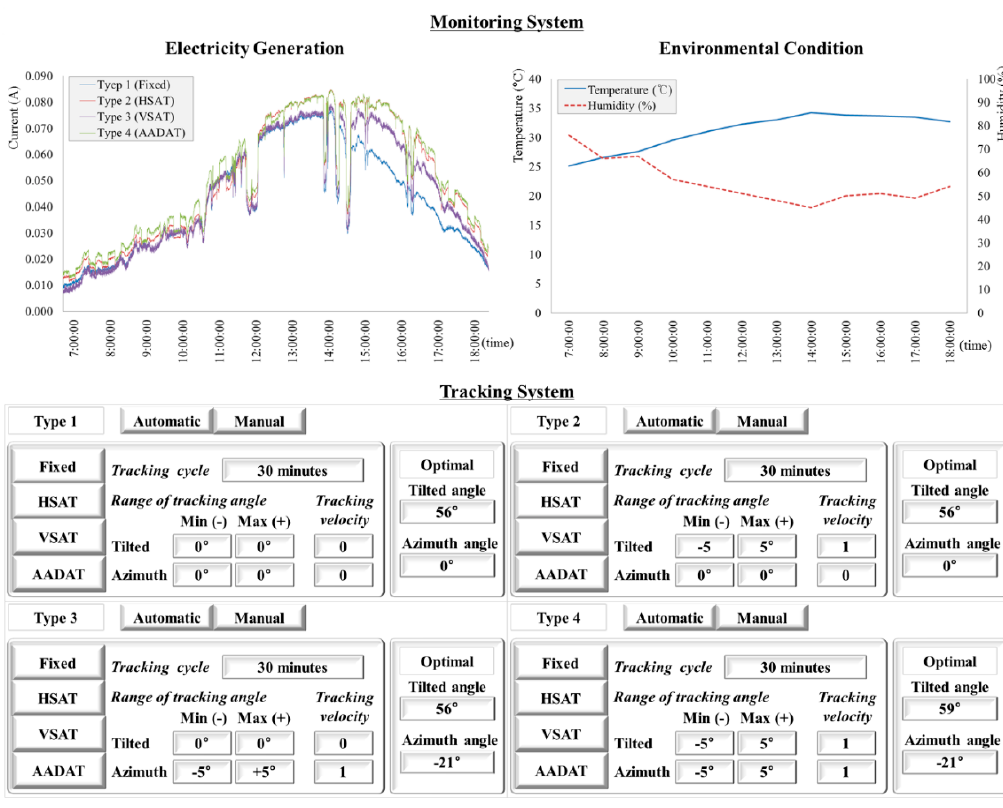
Figure 6. Graphical user interface of the monitoring system in the third prototype model.